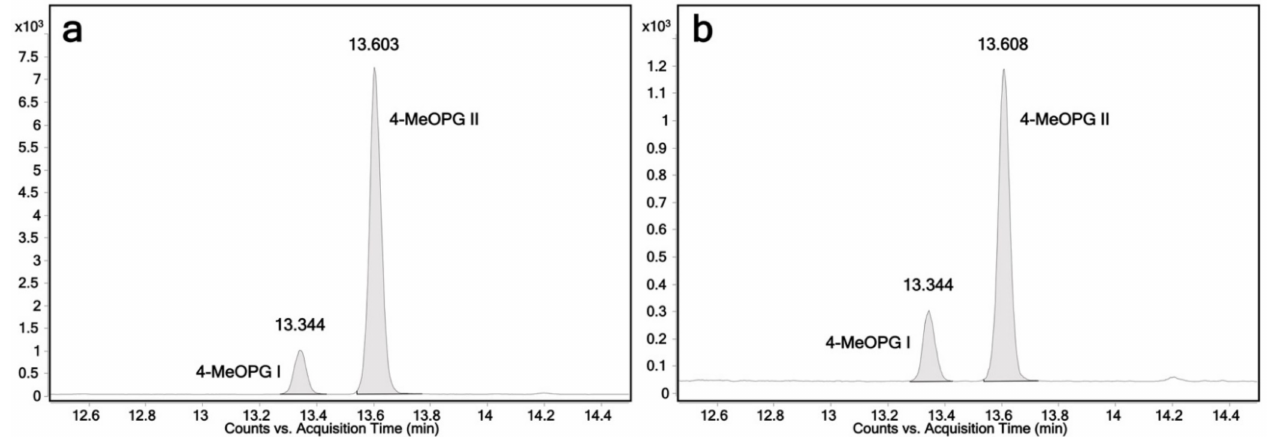
Figure 5. Chromatograms of 4-methoxypropranolol glucuronide I and 4-methoxypropranolol glucuronide II produced by UGT1A9 ( a ) and UGT2A1 ( b ). The displayed ion transition is m / z 466 → 116; 4-MeOPG I: 4-methoxypropranolol glucuronide I, retention time 13.3 min; 4-MeOPG II: 4-methoxypropranolol glucuronide II, retention time 13.6